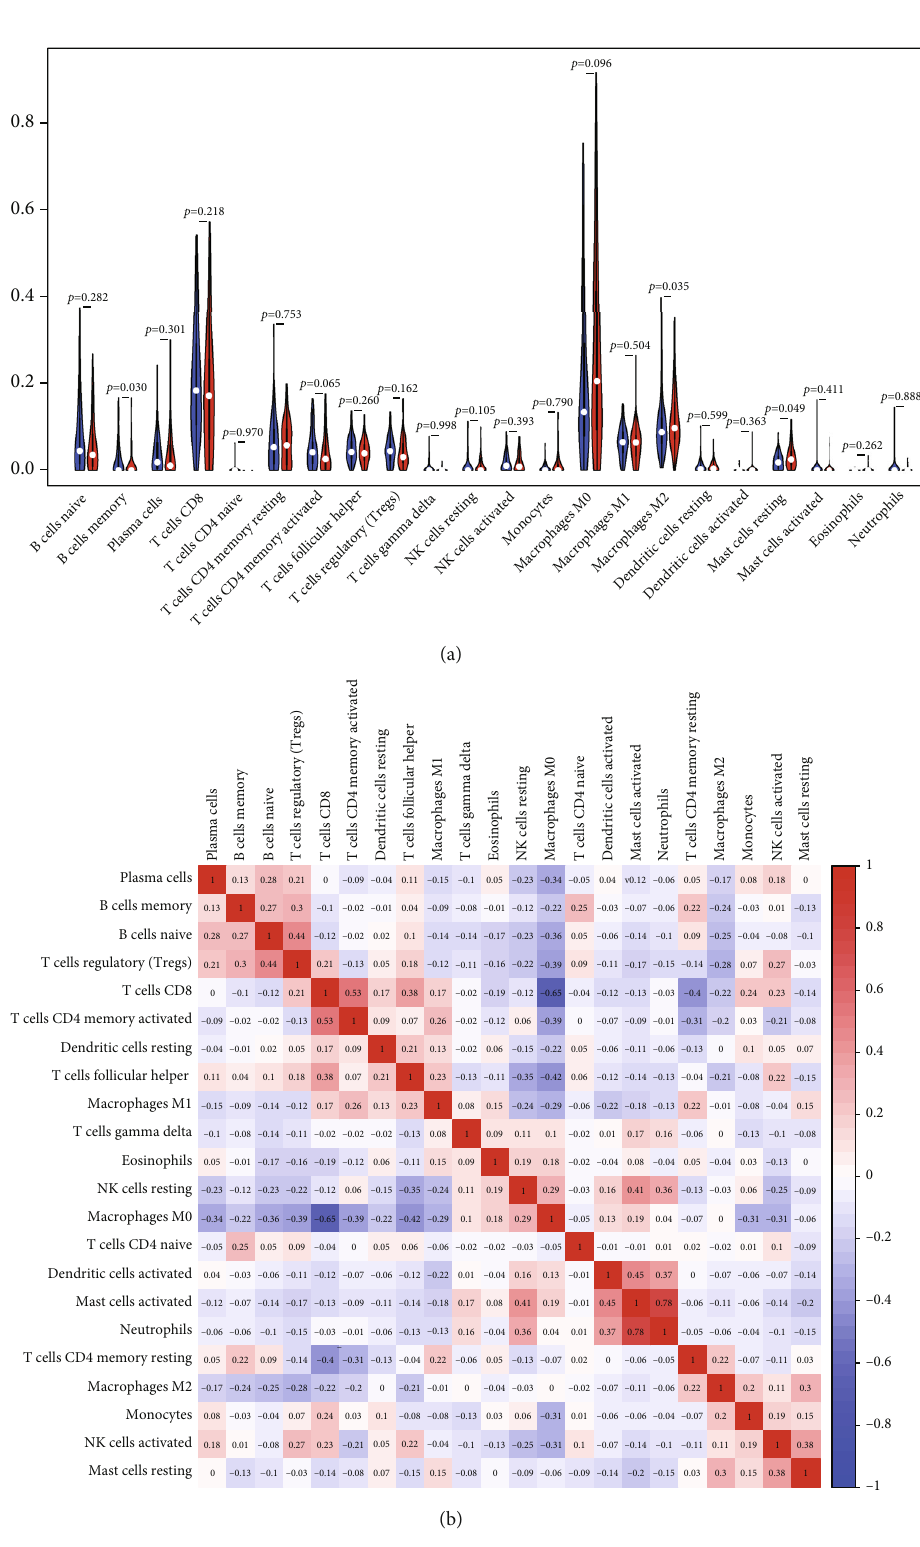
Figure 5: Results of TIIC relative ratio obtained by CIBERSORT algorithm: (a) comparison of the proportion of 22 immune cells in the low and high expression groups; (b) correlation degree matrix of relative proportions of immune cells in SKCM